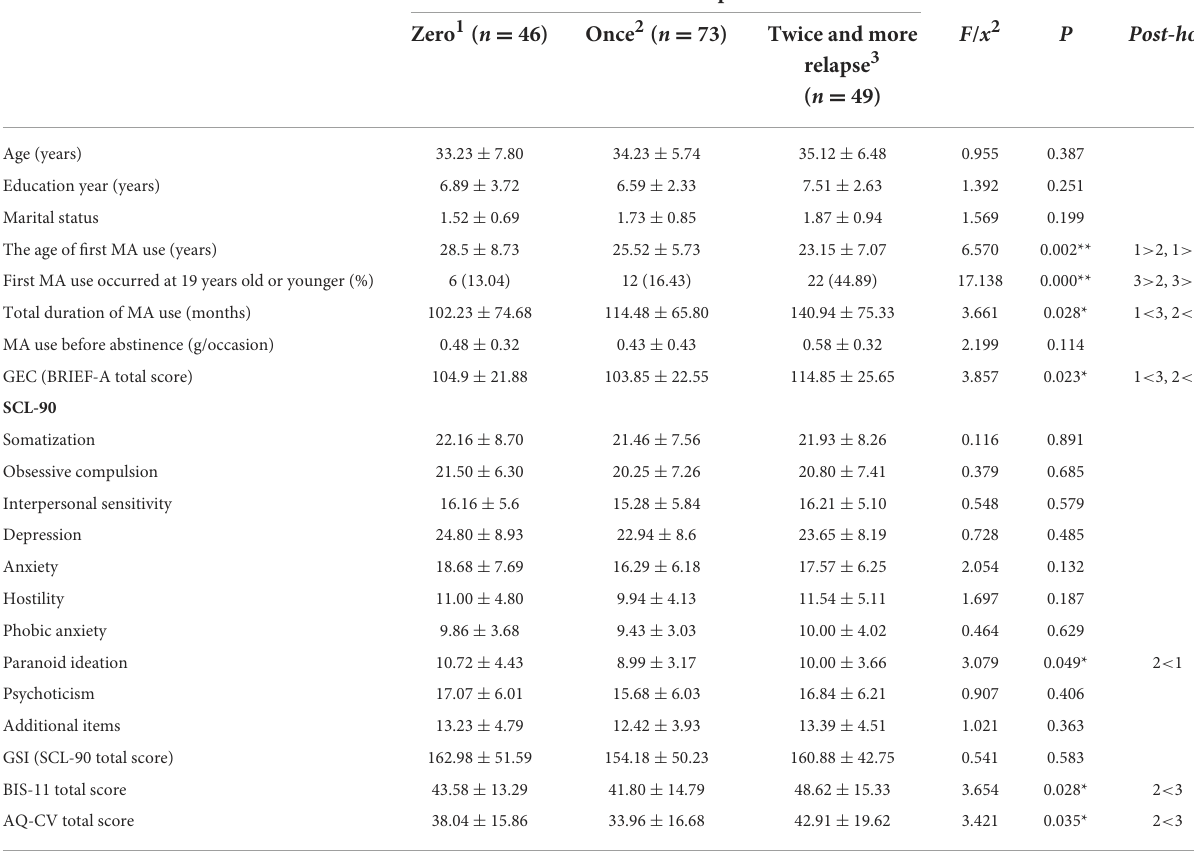
TABLE 4 Comparison of demographic information and psychological characteristics in MUD patients with different number of